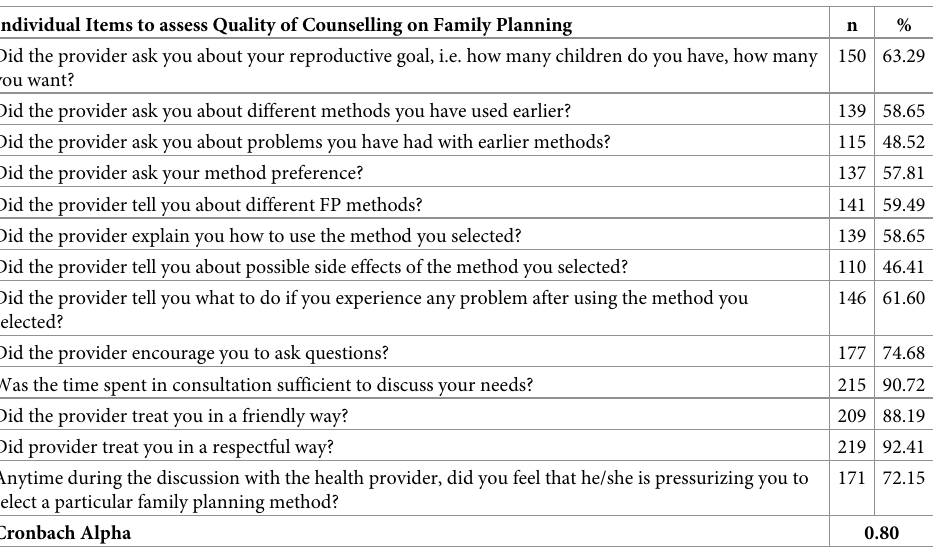
Table 3. Individual items used to assess Quality of FP Counselling (QFPC) (N = 237). Individual Items to assess Quality of Counselling on Family